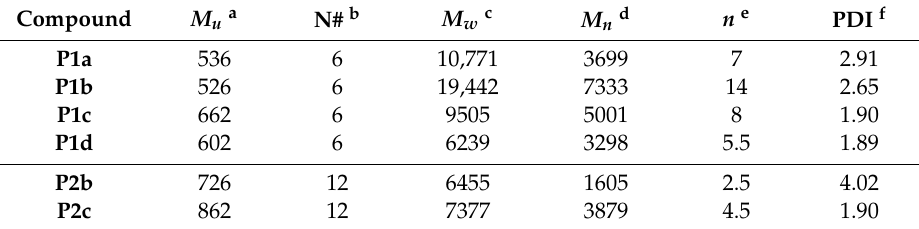
Table 1. Molecular weights distribution of co-oligomers P1 and P2 obtained by SEC-LS.